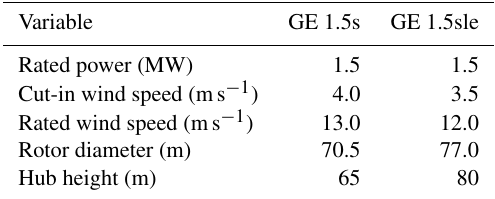
Table 1. General properties of the GE 1.5s and GE 1.5sle wind